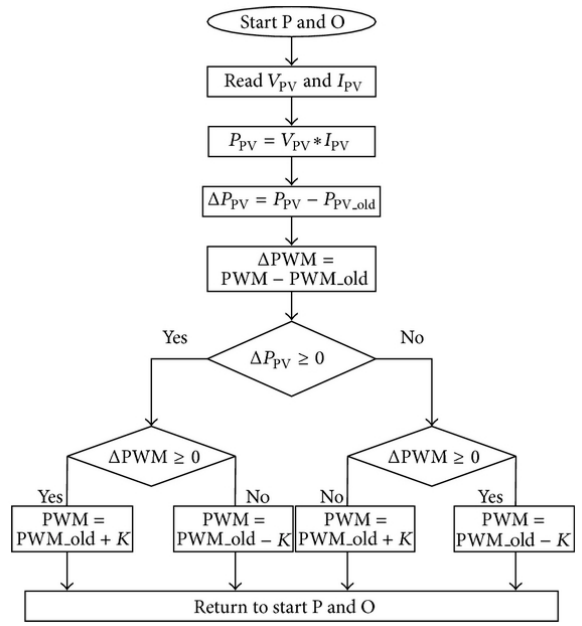
Figure 7. Flowchart of the Perturbation and Observation (P&O) algorithm.